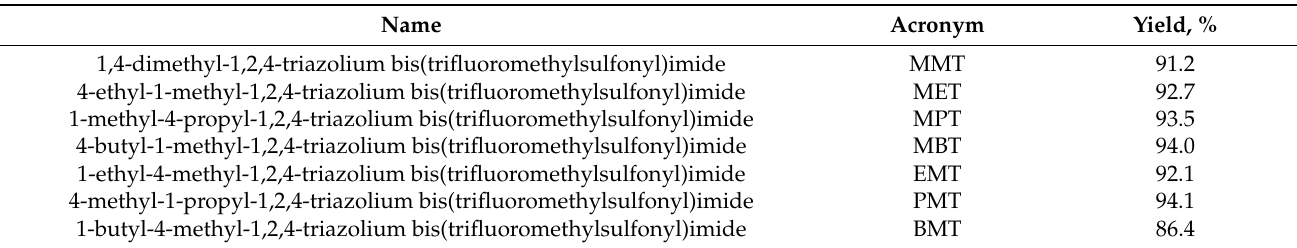
Figure 1. Synthesis of ionic liquids. Table 1. Synthesized ionic liquids.